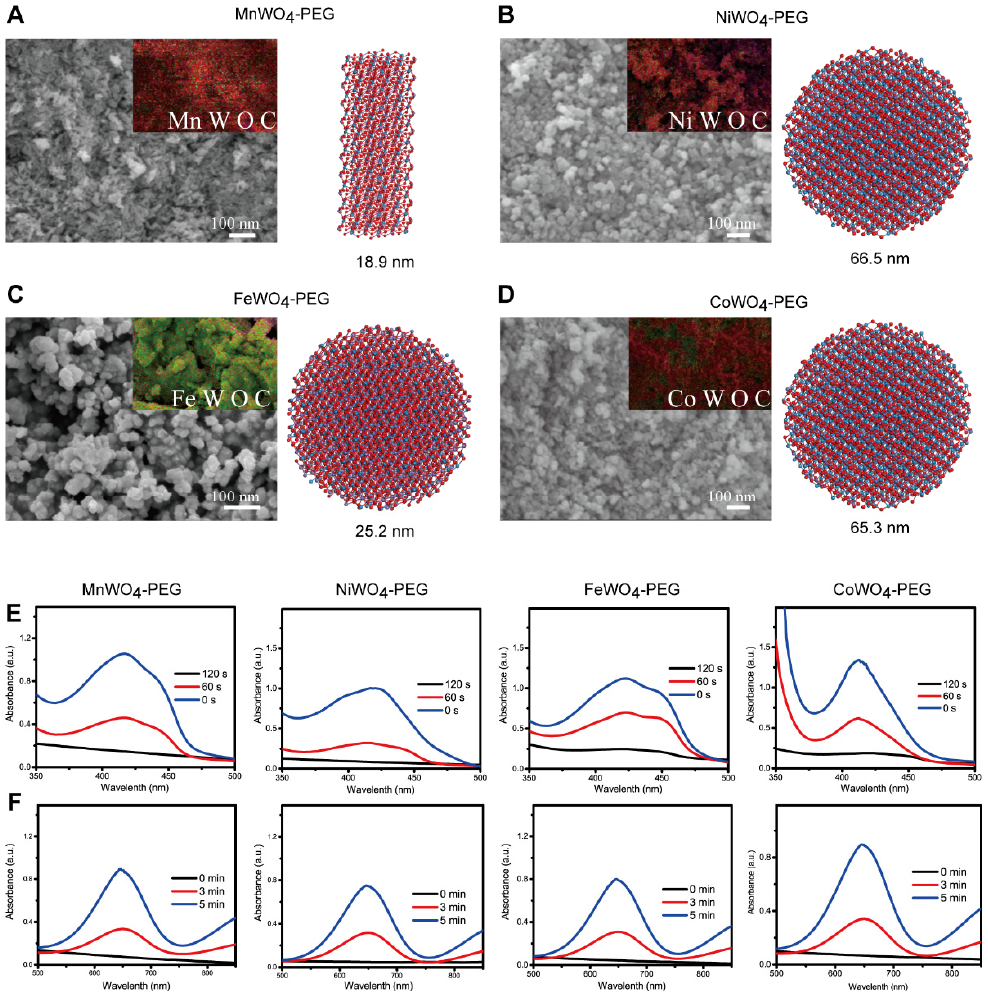
Figure 2. Characterization of MWO 4 -PEG NPs. The SEM images and the EDS images (the left), crystal structure and size (the right) of MnWO 4 -PEG NPs ( A ), NiWO 4 -PEG NPs ( B ), FeWO 4 -PEG NPs ( C ) and CoWO 4 -PEG NPs ( D ). The Time-dependent oxidation of DPBF indicates 1 O 2 generation by MWO4-PEG under US irradiation ( E ), and the Time-dependent oxidation of TMB due to •OH generation by MWO4-PEG under US irradiation ( F ).